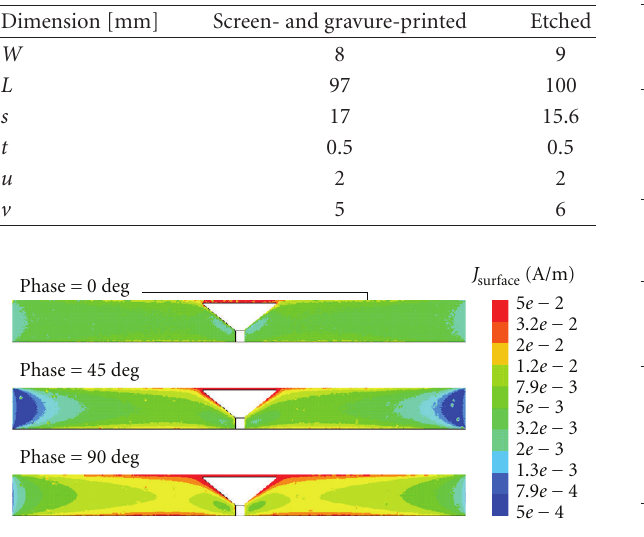
Figure 2: Simulated surface current density in the antenna structure under a plane wave incidence with di ff erent phases of incident wave.